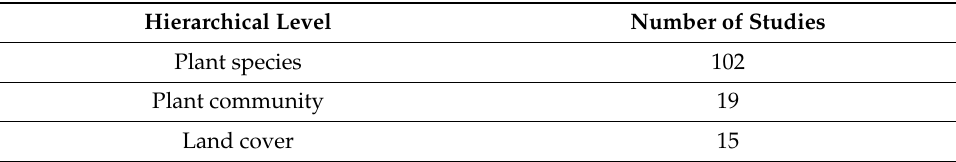
Table 4. Number of studies reviewed per hierarchical level of